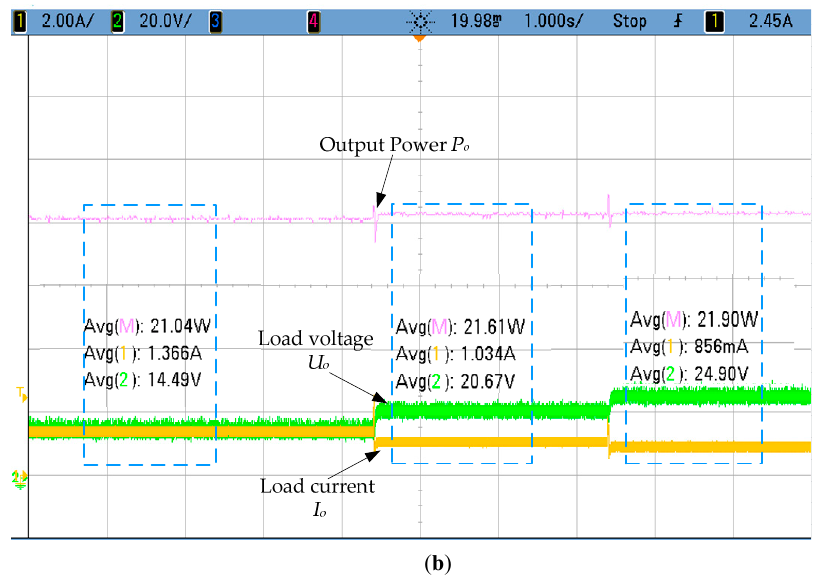
Figure 11. Experimental MPTT results when load R b changes with different k : ( a ) k = 0.0811; ( b ) k = 0.0448.